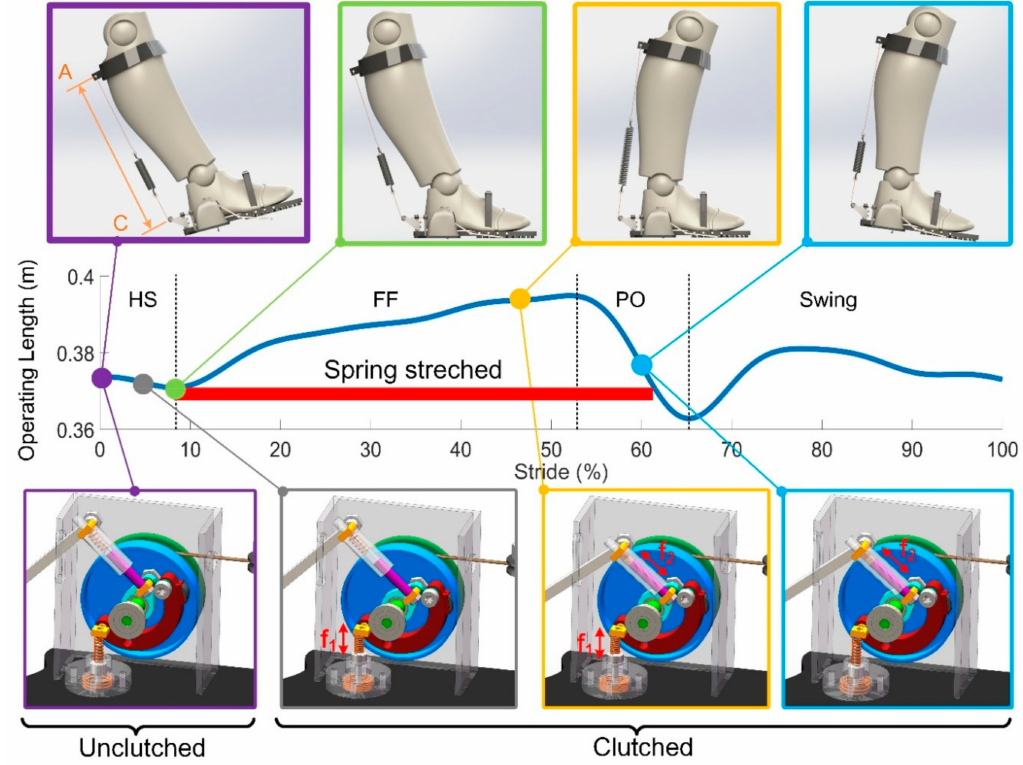
Figure 8. Schematics showing the working mode with respect to stride and the key event of the clever clutch in di ff erent gait